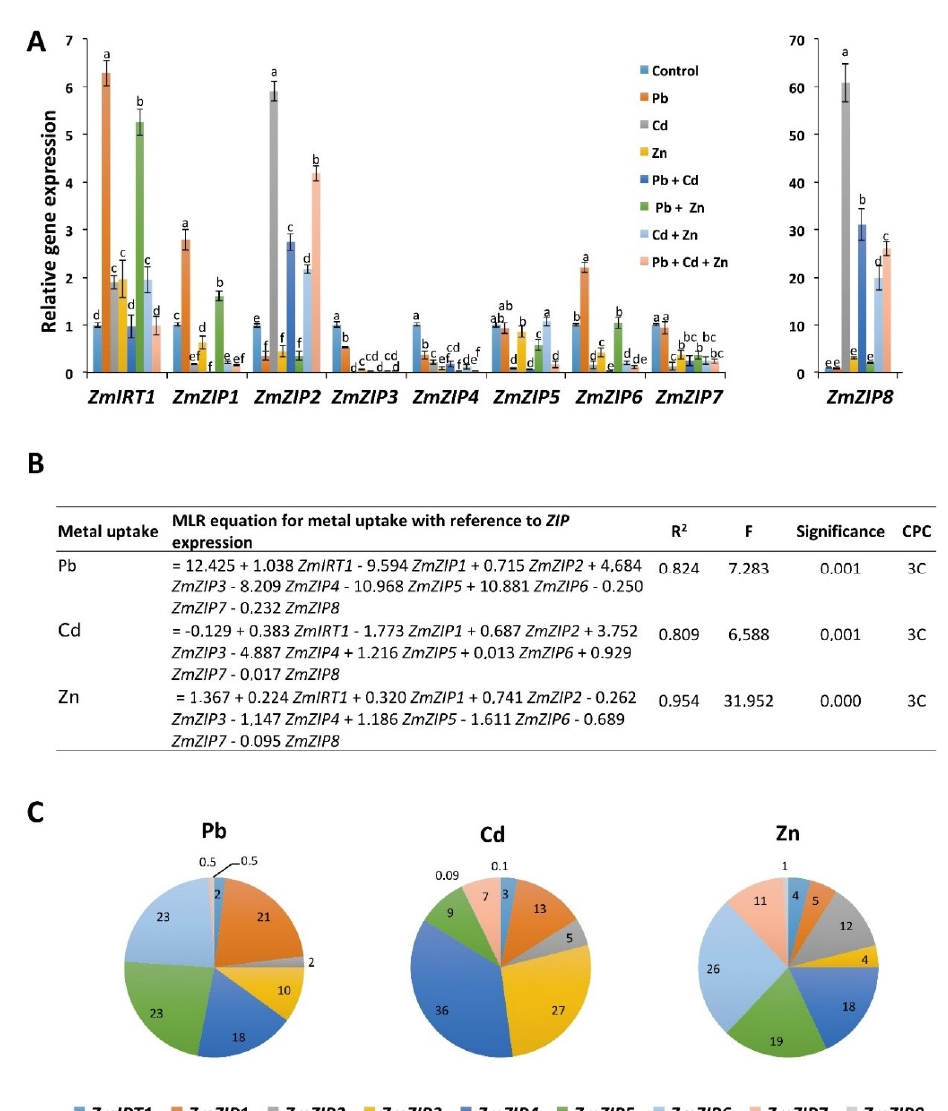
Figure 3. The expression of ZIP transporters in response to Pb / Cd / Zn applied alone and in combinations. ( A ) The expression of ZIP transporters was normalized with ZmUBQ5 . The data presented are the averages of three biological replicates. Bars represent mean ± SD. The values marked with di ff erent letters are statistically di ff erent ( p ≤ 0.05), while the values marked with the same letters do not di ff er significantly. ( B ) Multiple linear regression (MLR) equations for uptake of each heavy metal and expression of ZIP transporters. ( C ) Cumulative percentage contribution (CPC) for the expression of each ZIP transporter in response to the uptake of heavy metals.